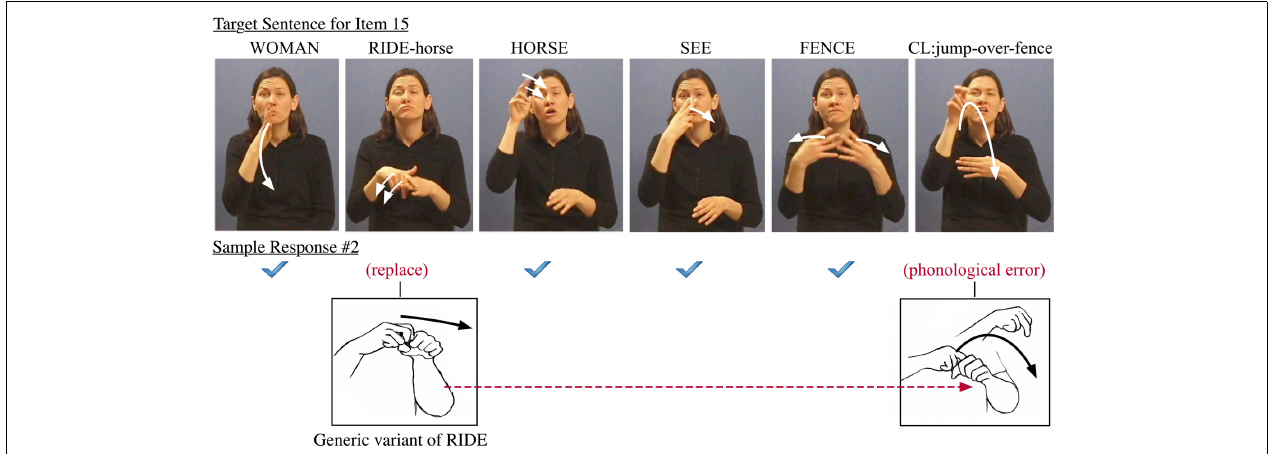
FIGURE 7 | Another example of error made for sentence item